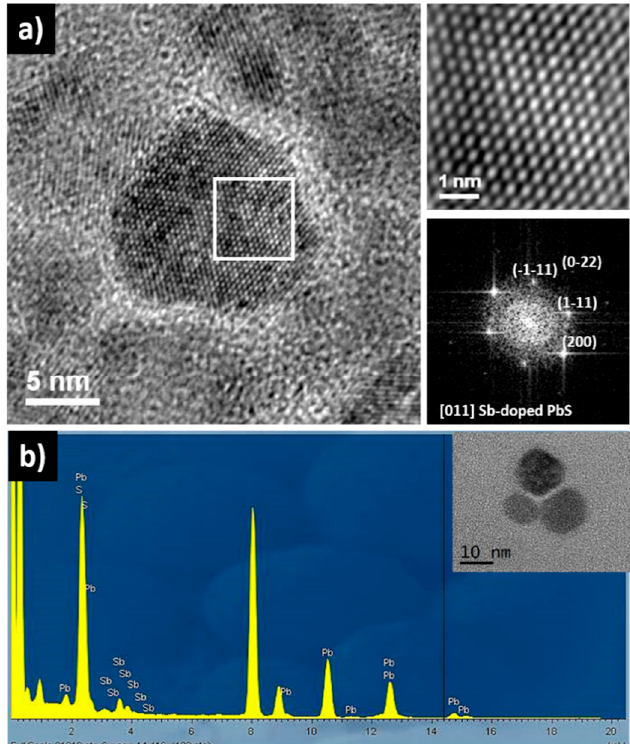
Figure 2. ( a ) HRTEM micrographs of Pb 1 − x Sb x S NCs for x = 0.15, the crystal structure could be in-